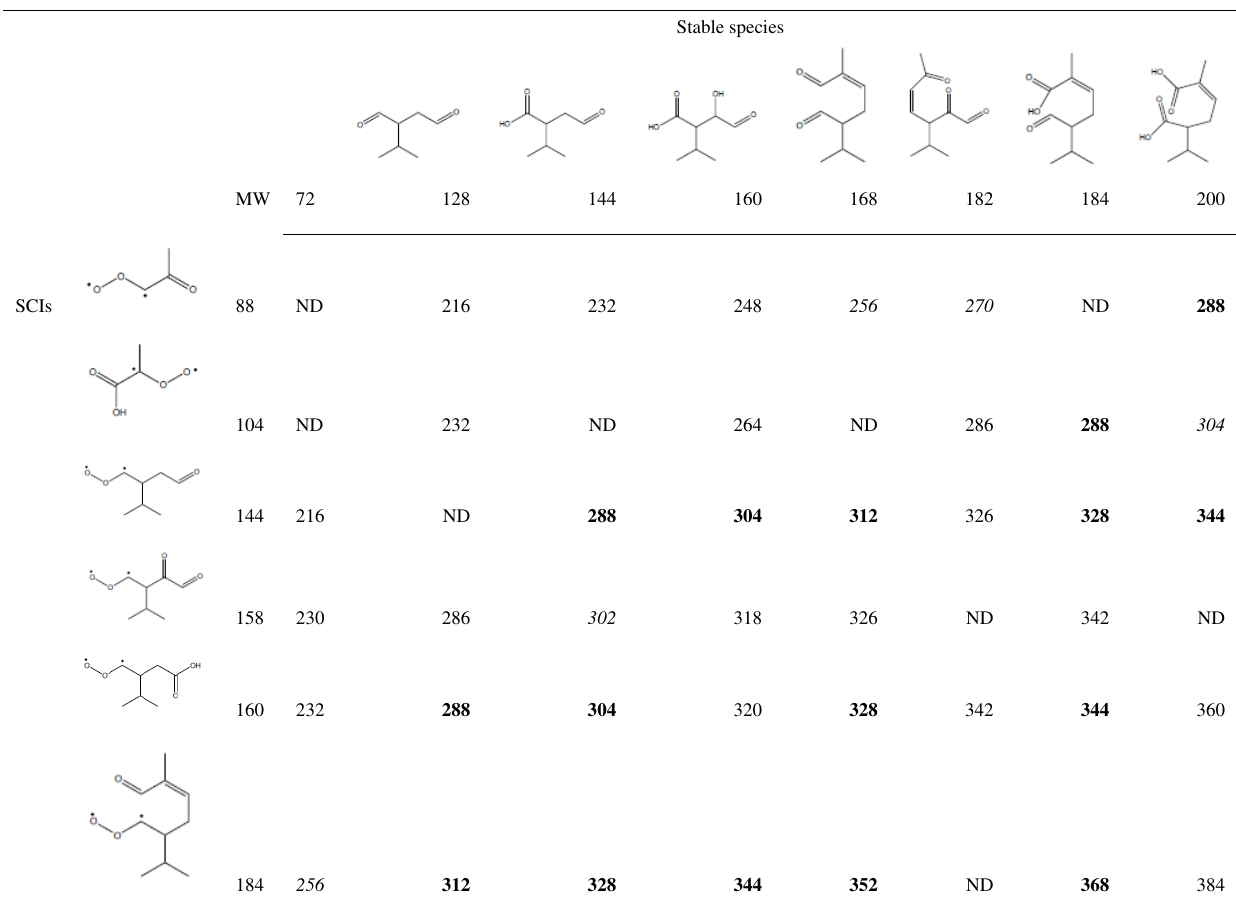
Table 4. The m/z values of possible dimer products from α -phellandrene ozonolysis formed from the reaction of SCIs with non-radical ozonolysis products. Reaction of SCIs with carbonyls forms secondary ozonides whilst reaction with acids yields acyloxyalkyl hydroperox- ides dimers. Masses in bold were reduced upon introduction of a SCI scavenger, masses in italics had increased abundance upon addition of a SCI scavenger, and masses in normal font remained similar or were inconsistent upon introduction of a SCI scavenger. ND denotes that the proposed mass was not detected in the ESI mass